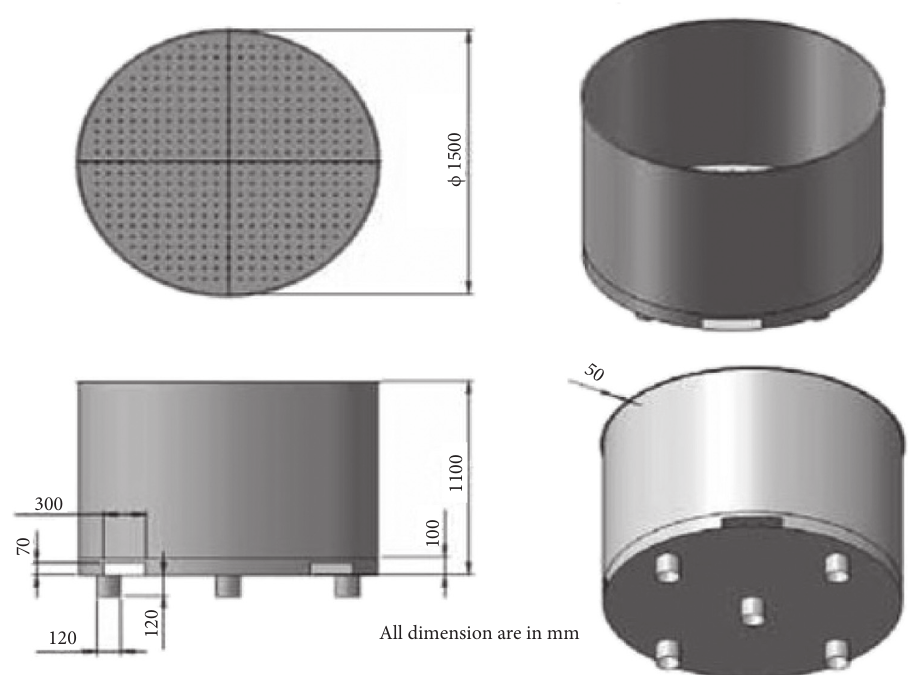
Figure 5: Charcoal